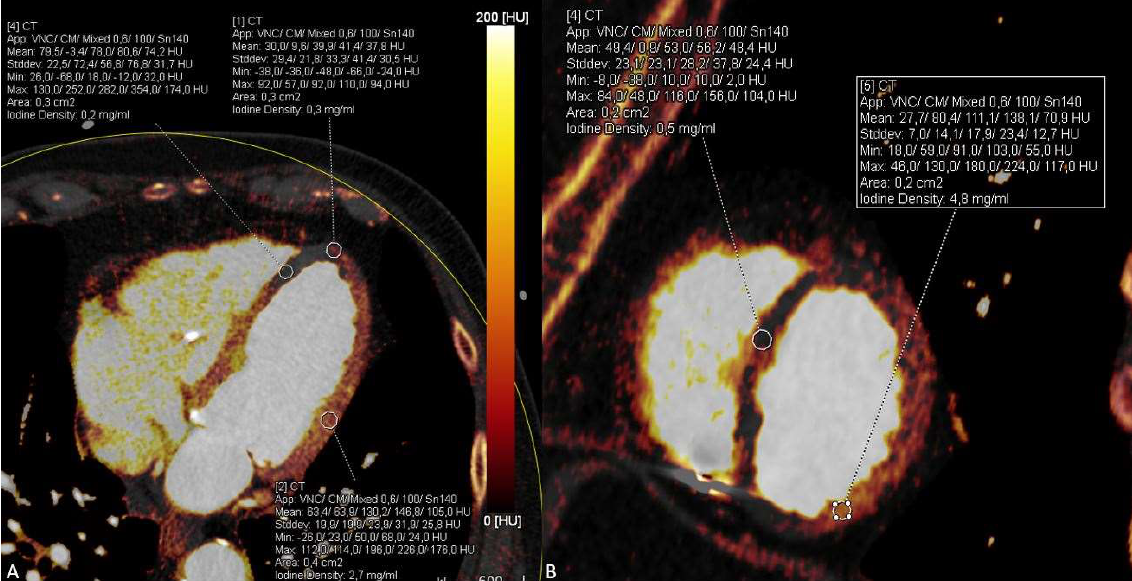
Figure 3. Significant hypoperfusion of the anterior wall and anterior septum is visible and can be quantified on dual-energy CT iodine maps using the four chamber view ( A ) and short axis view ( B ) indicating acute myocardial infarction in this area due to the LAD